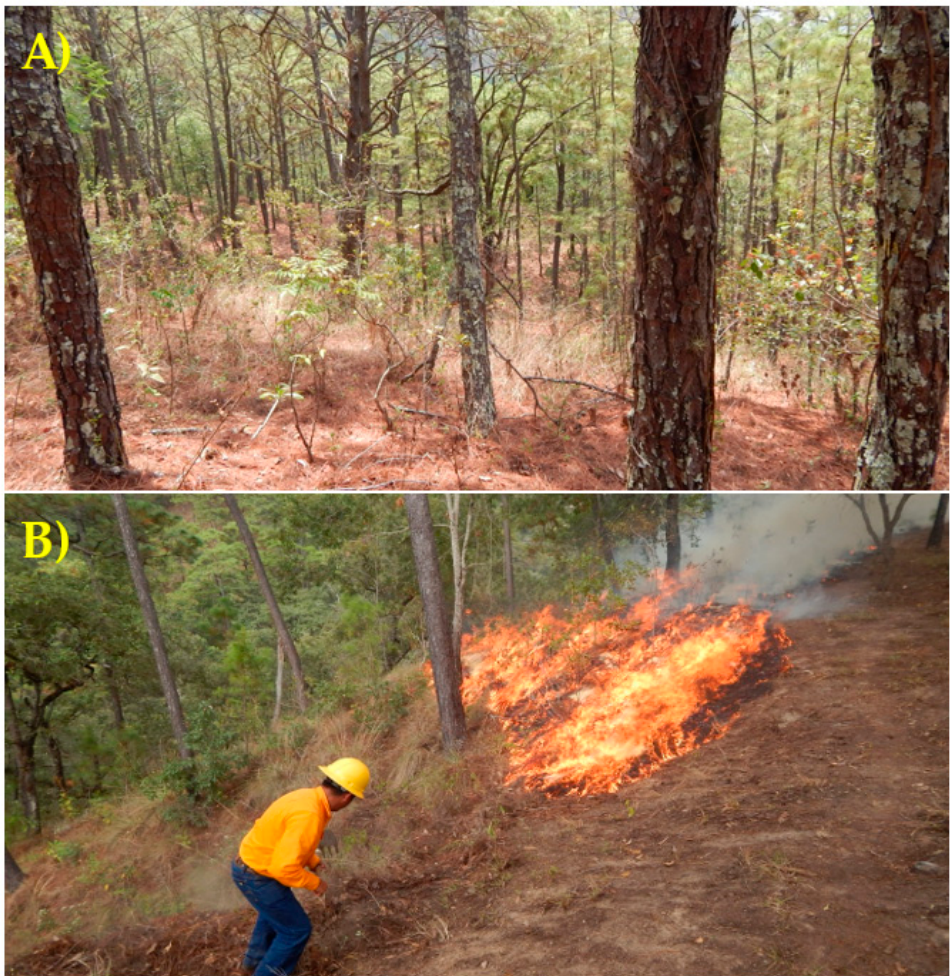
Figure 2. Images of forest ecosystems representing vegetation type ( A ) and prescribed burning process ( B ). Photos were taken from study sites located in Chiapas, Mexico. (Photo: Alonso López-Cruz.)